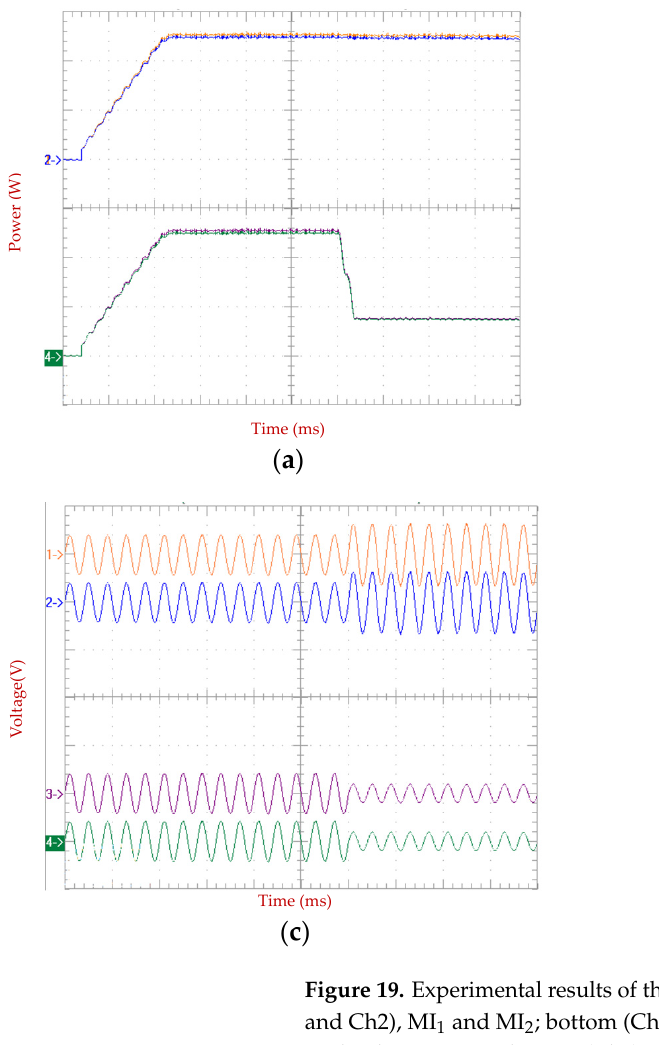
Figure 18. Control loops during the PV to grid inversion: k p = 2.5 and k r = 5. ( a ) Bode plot. ( b ) Pole- zero map.